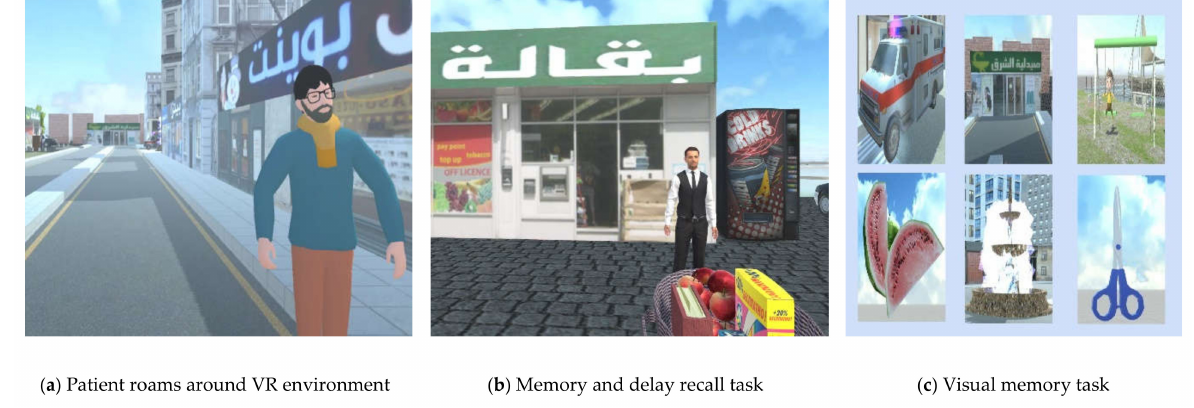
Figure 4. VR system to diagnosing dementia